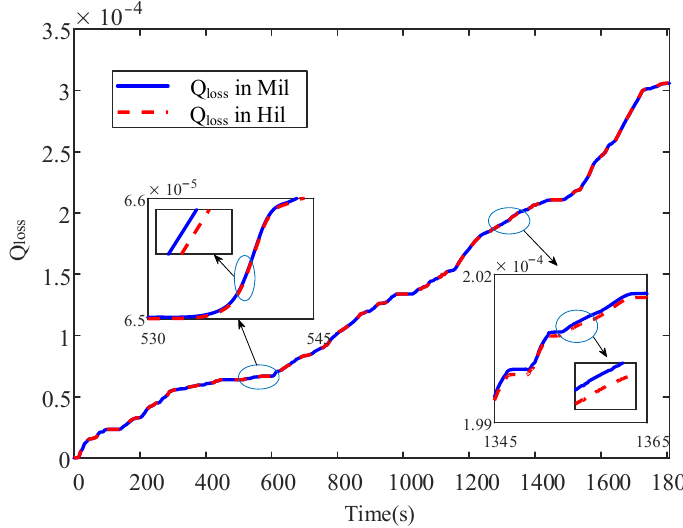
Figure 22. Q loss compariso between simulation and Hil.